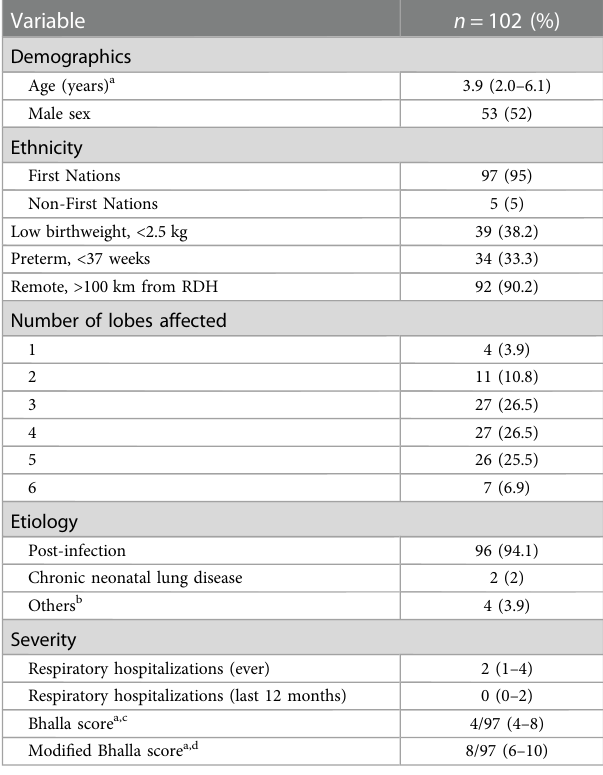
TABLE 1 Baseline characteristics at time of bronchiectasis